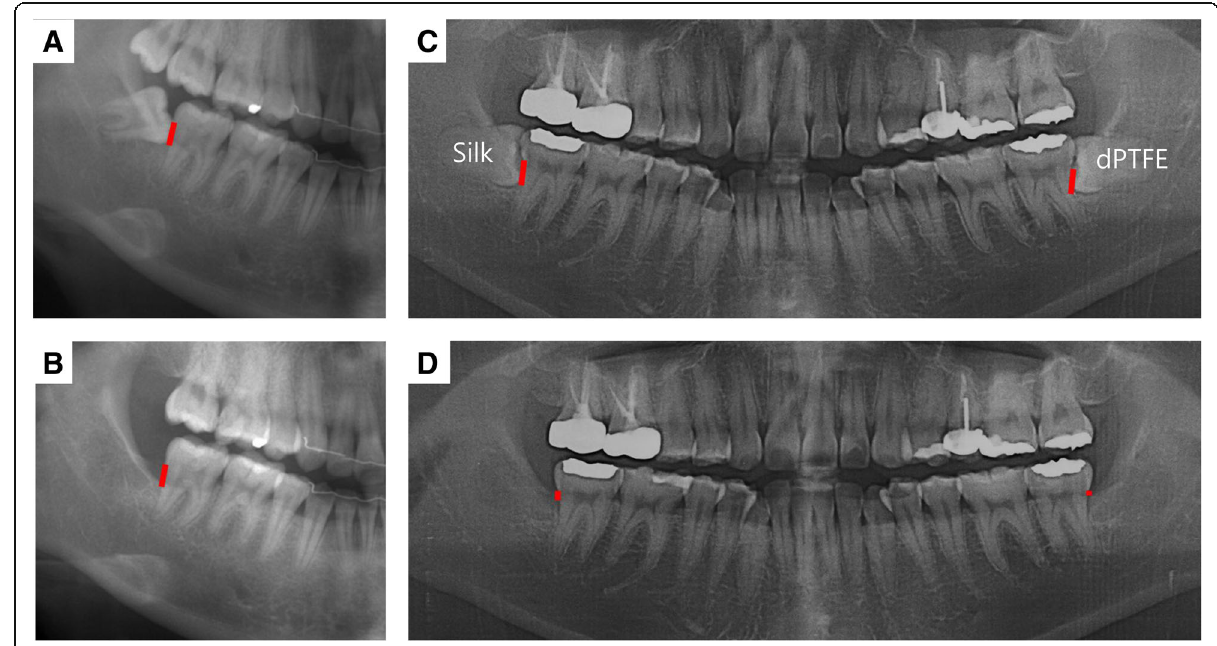
Fig. 2 Measurement of the bony defect. Bony defect is the distance between the cement – enamel junction and the bottom of the bony defect on the distal surface of the second molar. The amount of a bony defect is indicated as a red bar on the panoramic view. a No membrane group before extraction. b No membrane group at 6 months after extraction. c Membrane group before extraction. The patient had bilaterally impacted third molar. In this patient, silk mat was applied to the right side and dPTFE to the left side. d Membrane group at 6 months after extraction